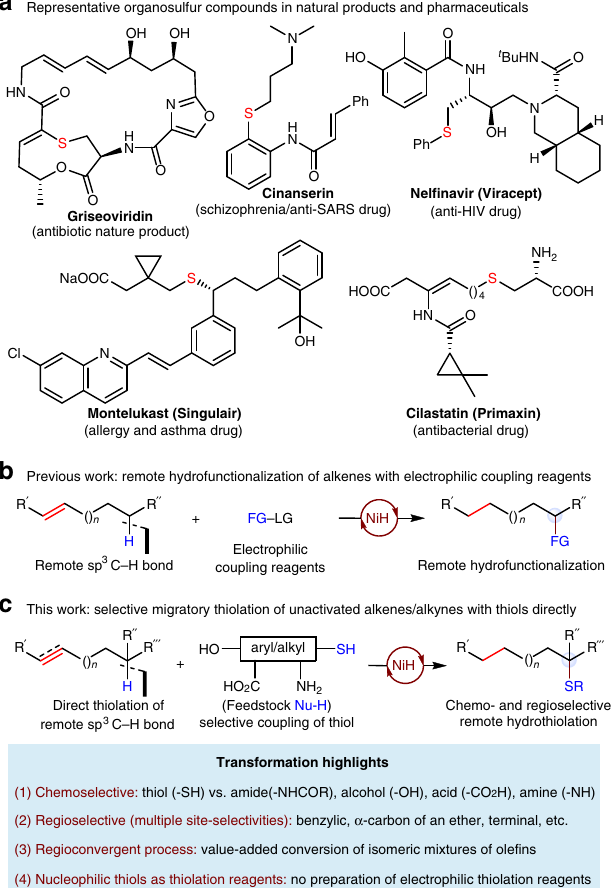
Fig. 1 Design of a NiH-catalyzed remote hydrothiolation reaction. a